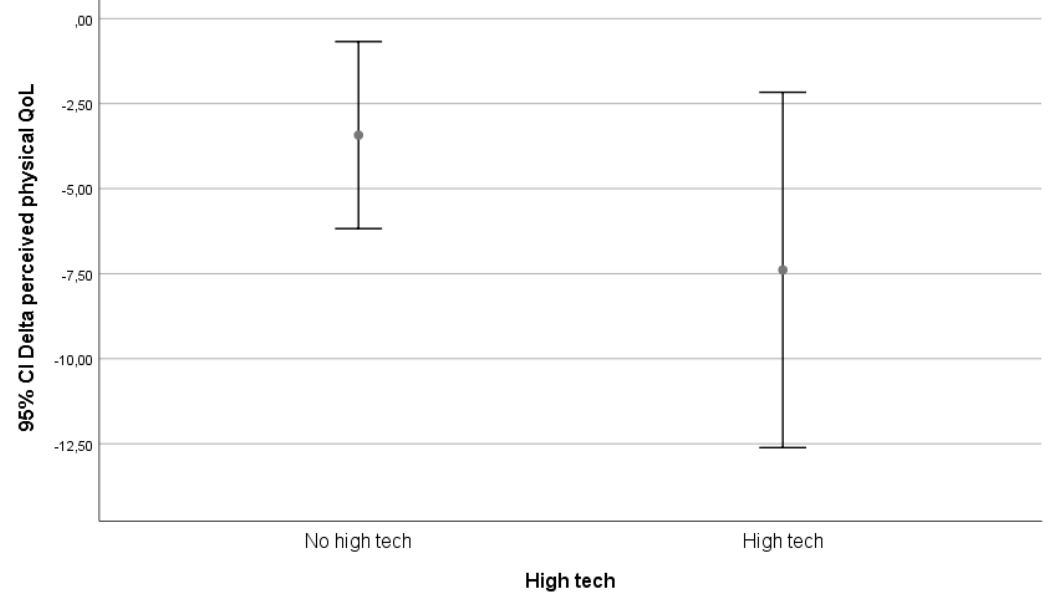
Figure4. Relationbetweendeltaperceivedphysicalhealth(SF-12 (physical health T12) –SF-12 (physical health T0) ) Figure 4. Relation between delta perceived physical health (SF-12 (physical health T12) – SF-12 (physical health T0) ) and match to high-tech and match to high-tech technology.